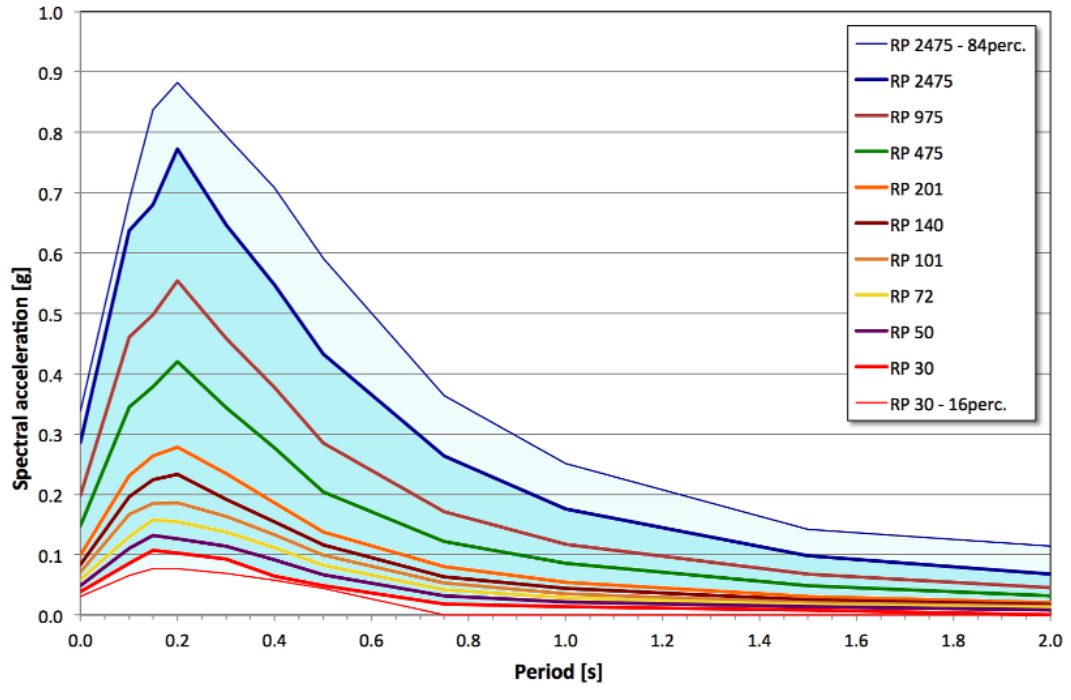
Figure 4. Acceleration uniform hazard spectra for several return periods (as indicated) considered in MPS04 at the grid point closest to the Mirandola (MRN) station.